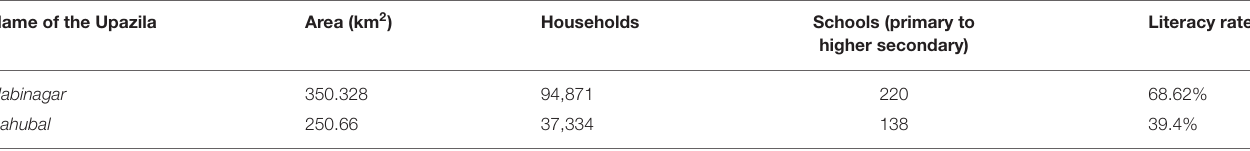
TABLE 2 | Relevant demographics of the selected two Upazilas (GoB, 2020). Name of the